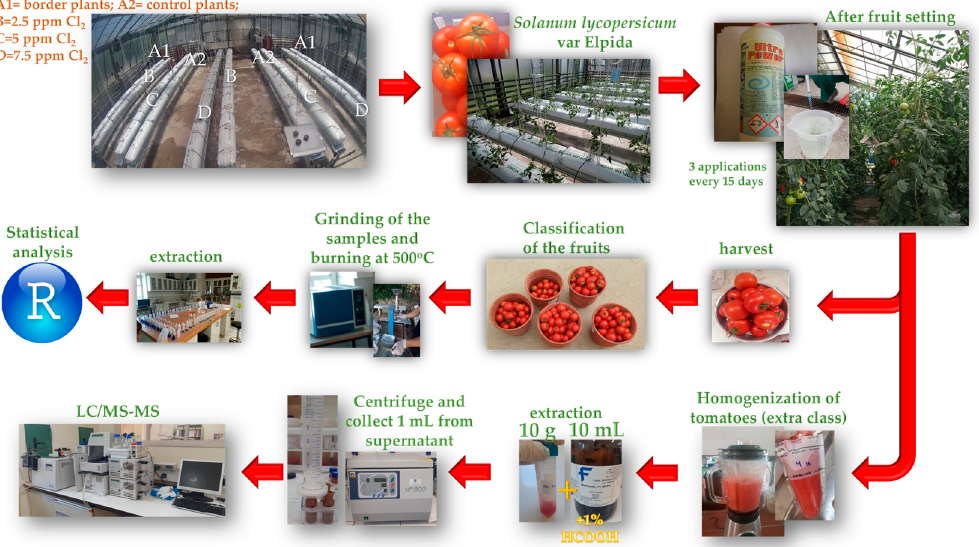
Figure 3. Experimental pipeline for the study of the impact of sodium hypochlorite applied as a nutrient solution disinfectant on growth, nutritional status, yield, and consumer safety of tomato fruit produced in a soilless cultivation.